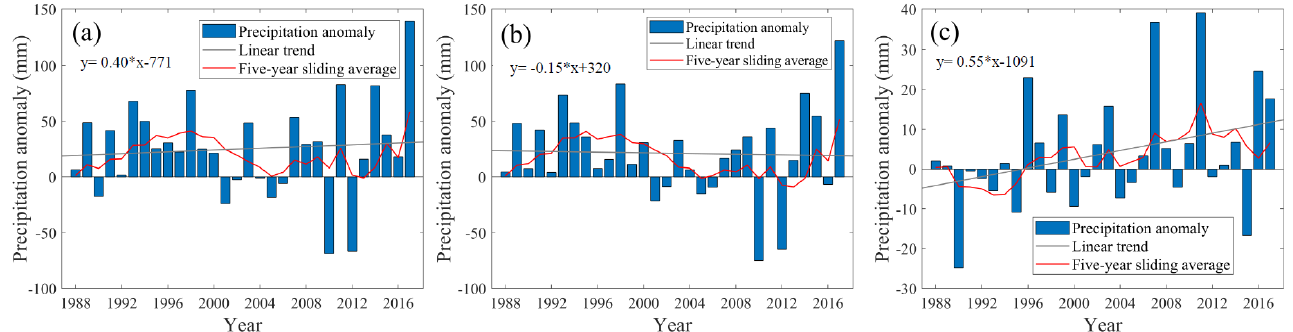
Figure 3. Change of precipitation for the ( a ) whole year, ( b ) flood season, and ( c ) dry season in the TGRA from 1988 to 2017.